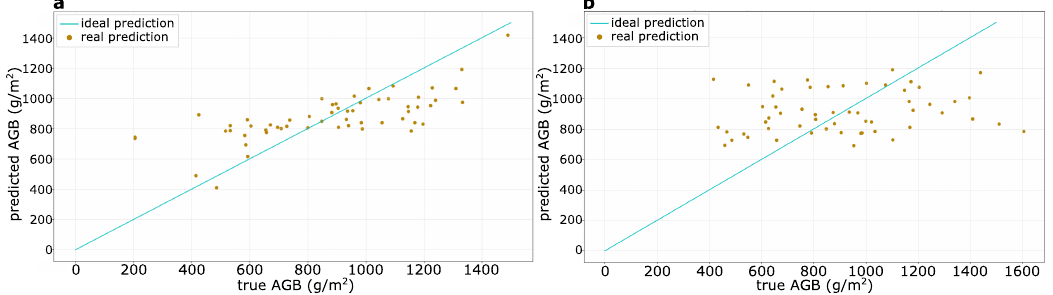
Figure 10. The AGB predictions for the barley crops at a 0.35 m 2 resolution that were produced by the ERT model compared to those that were produced by the linear model (baseline): ( a ) the regression performance of the ERT model using the testing dataset ( R 2 = 0.48; RMSE = 207 g/m 2 ; MAE = 162 g/m 2 ; MAPE = 42%); ( b ) the regression performance of the linear model using the testing